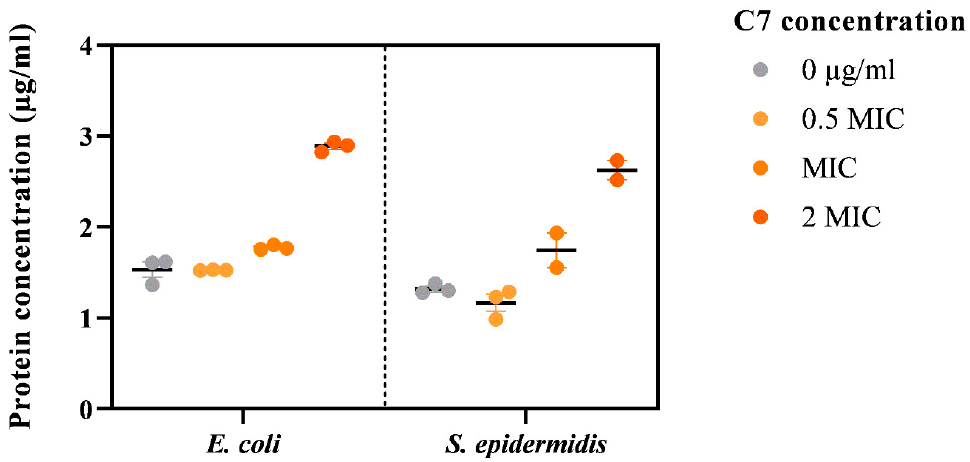
Figure 3. Effect of C7 on E. coli and S. epidermidis membrane ( n =